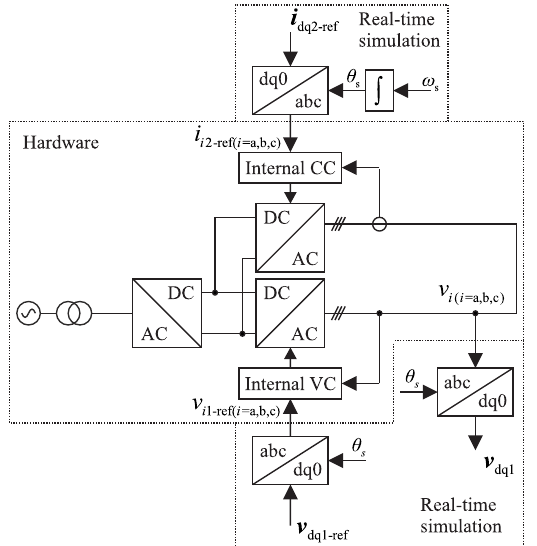
Figure 3. Test setup to measure closed-loop frequency response of the voltage amplifier under loaded condition.